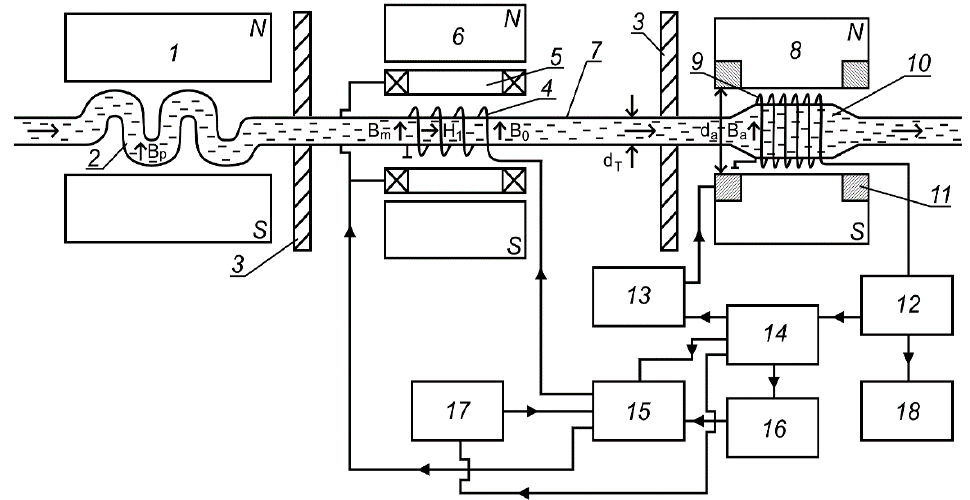
Figure 1. Structural diagram of the design of the NMR flowmeter–relaxometer: 1—magnet polarizer; 2—vessel polarizer; 3—magnetic screen; 4—nutation coil; 5—field modulation coils B 0 ; 6—constant magnet; 7—connecting section of pipeline; 8—magnet analyzer; 9—NMR signal registration coil; 10—vessel analyzer; 11—modulation coils of the magnet analyzer field; 12—NMR signal registration scheme; 13—radio frequency generator; 14—scheme of processing and control; 15—electronic keys; 16 and 17—nutation and modulation coil generators; 18—oscilloscope.